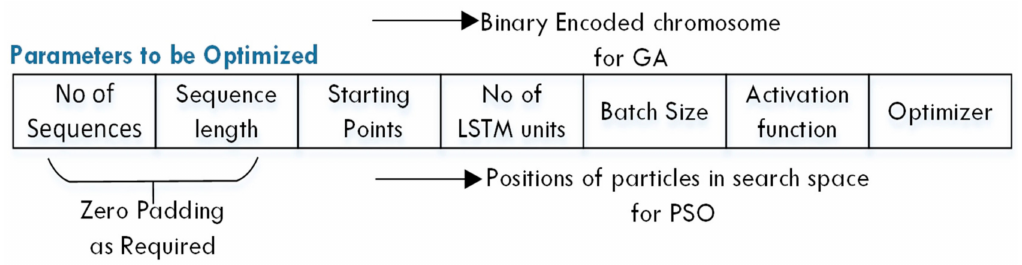
Figure 9. Binary Encoding for the